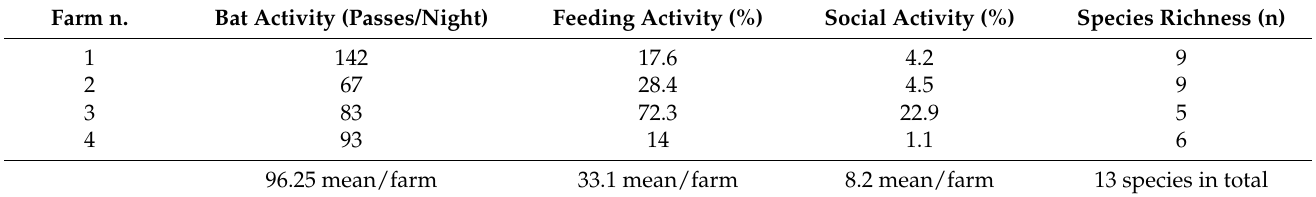
Table 1. Bat activity and biodiversity estimated using bioacoustics